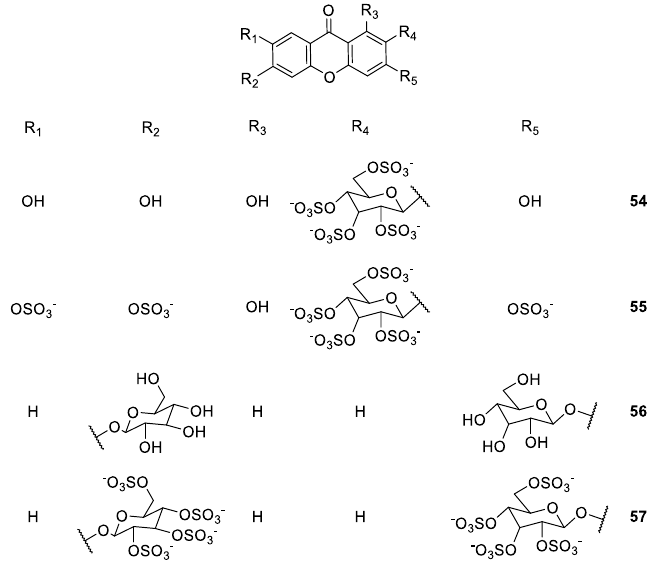
Figure 7. Structures of mangiferin derivatives 54 – 57 with anticoagulant and antiplatelet